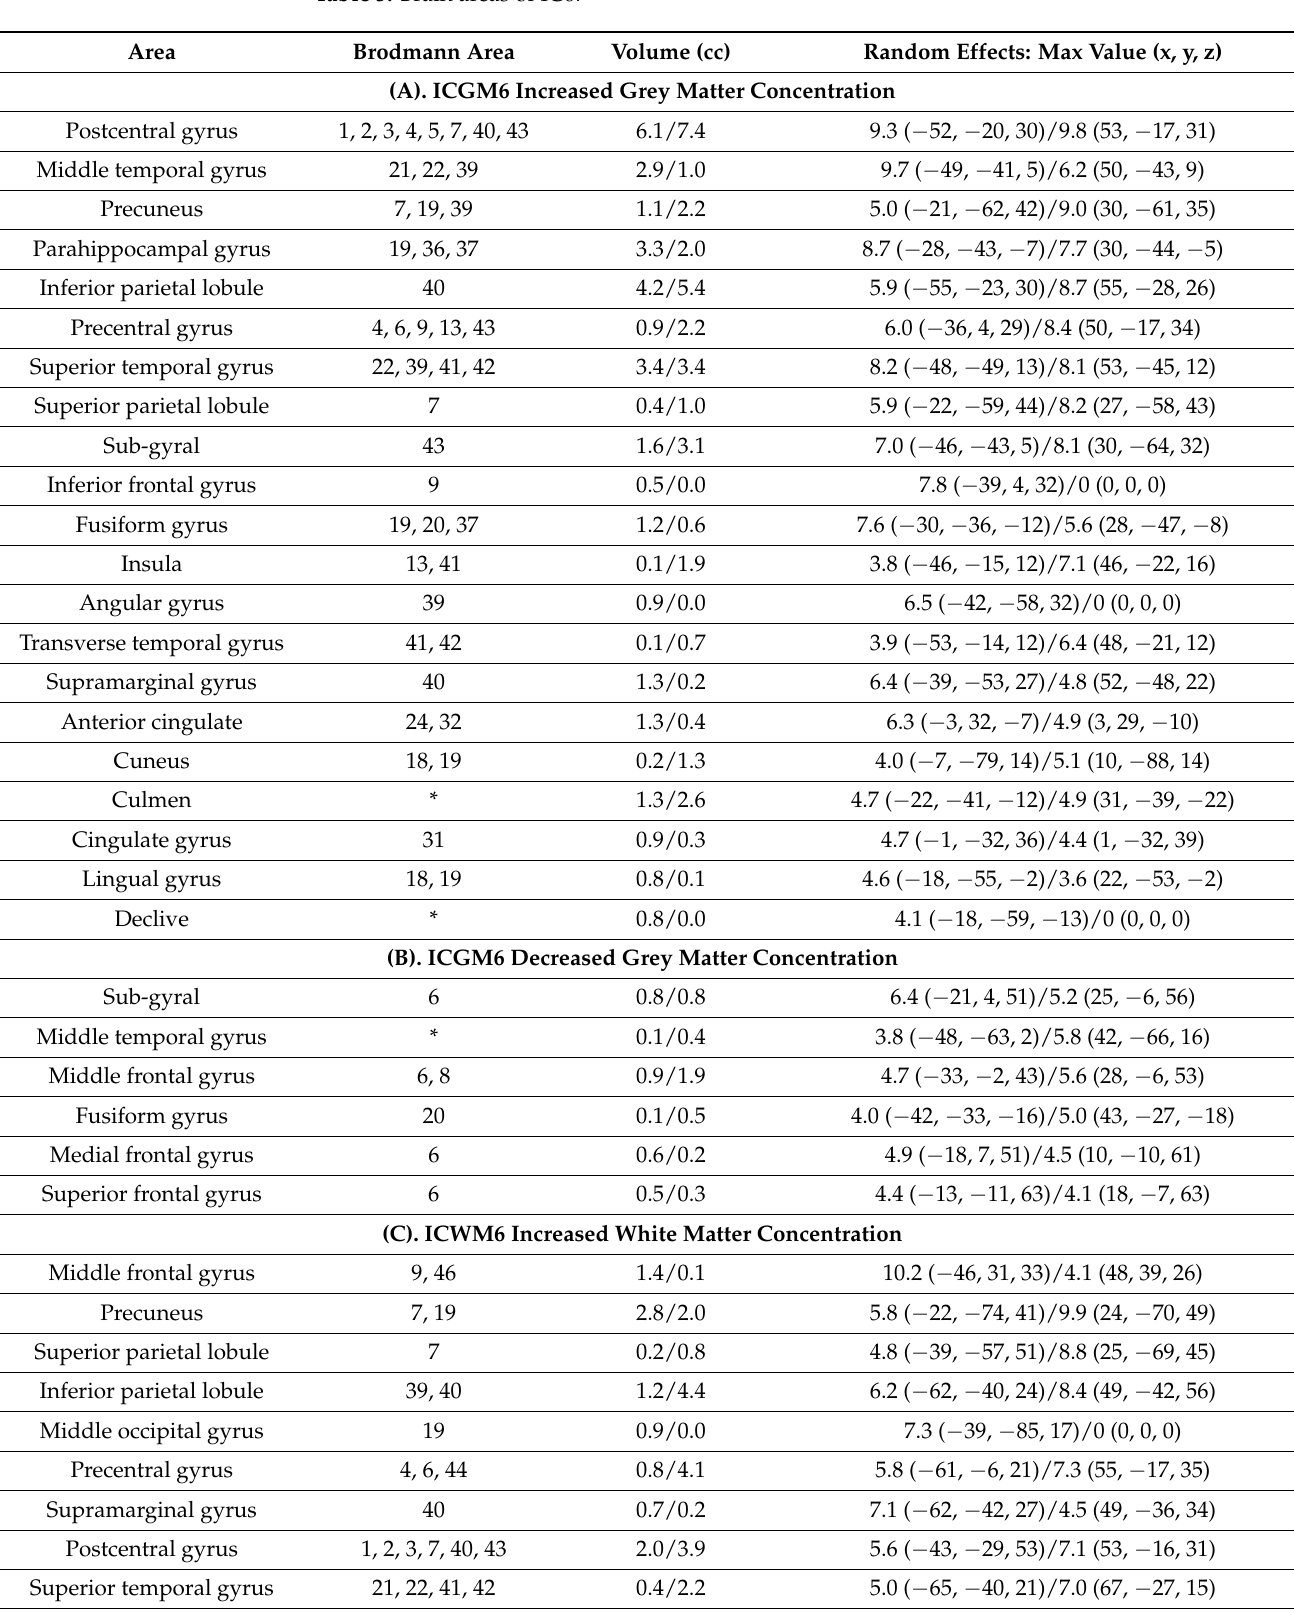
Table 3. Brain areas of